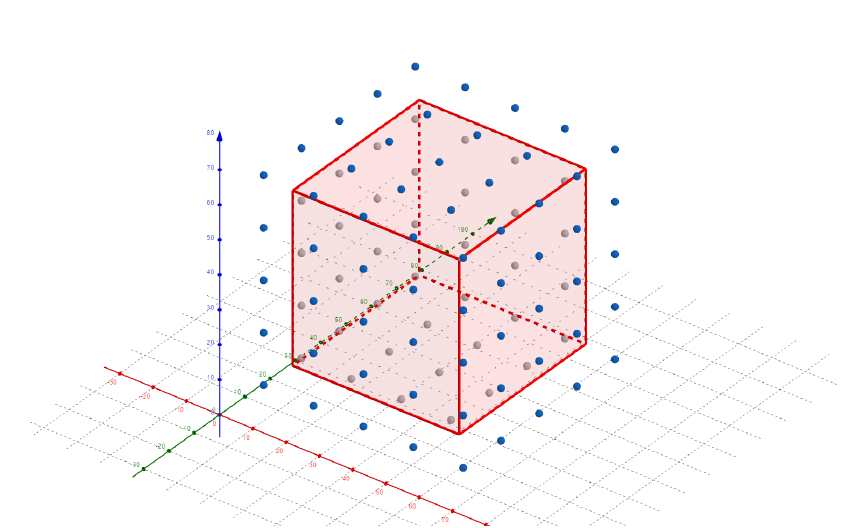
Figure 19. 75 m × 75 m × 75 m 98 nodes grid deployment with void.